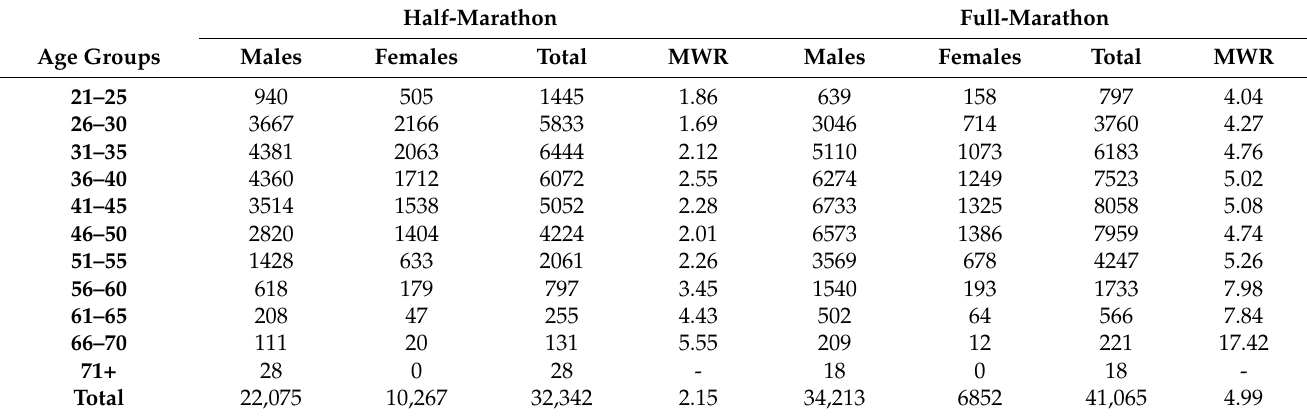
Table 1. Distribution of male and female finishers in each age group and race